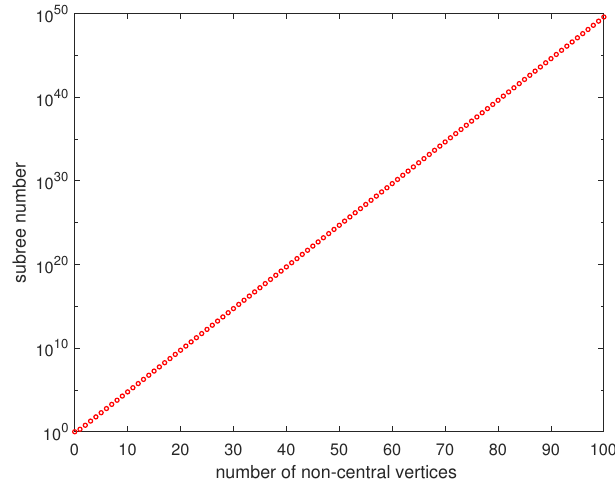
Figure 2. Number of subtrees of K j